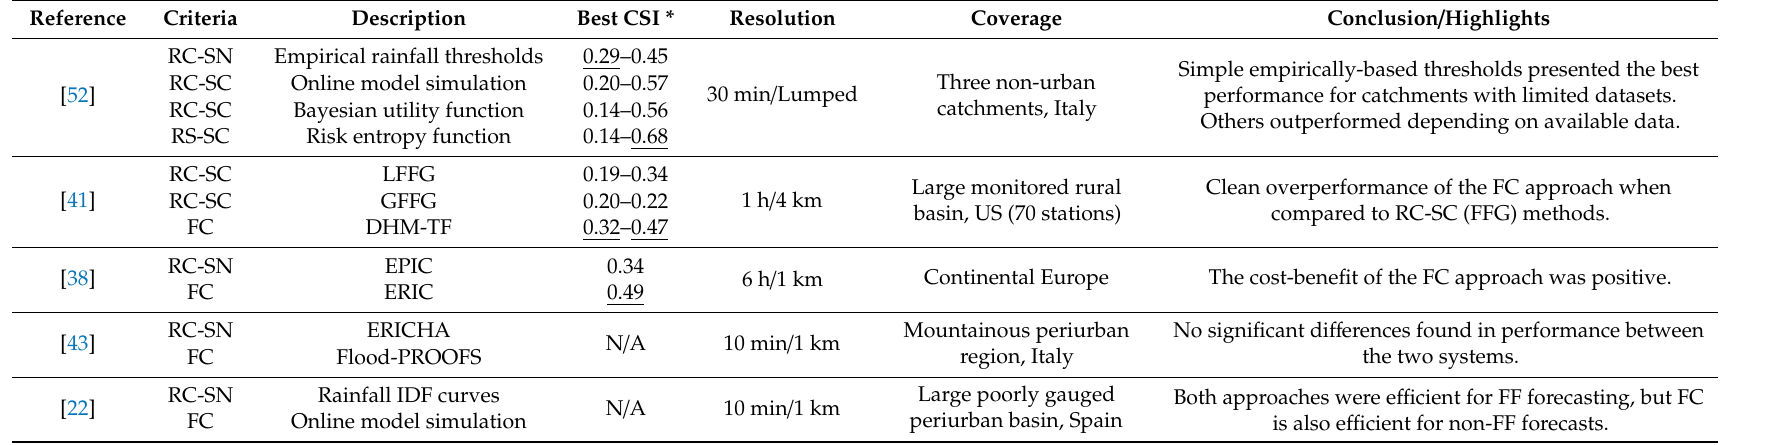
Table 2. Summary of results from selected comparative works of systems based on di ff erent flash flood identification